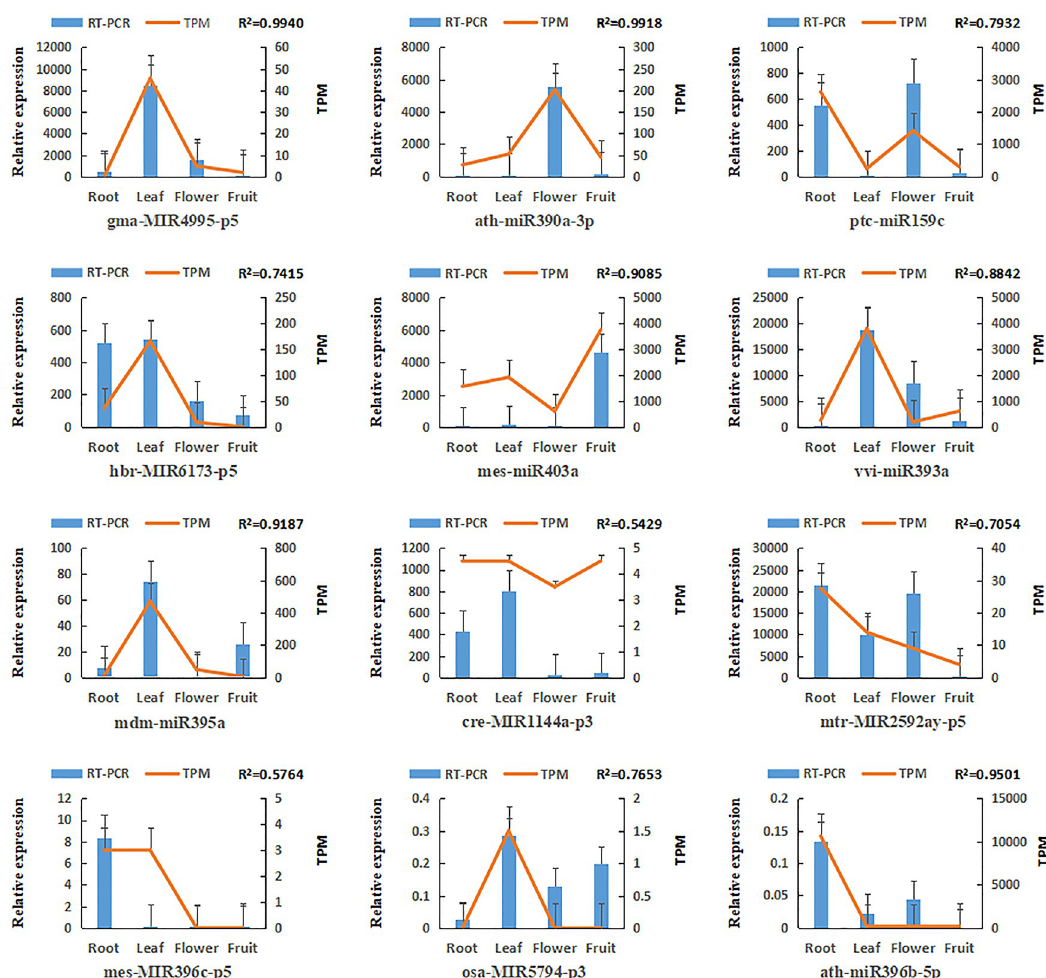
Fig 11. Expression levels of 12 miRNAs. (The bar charts and linear diagrams indicate the RT-qPCR and TPM data of the miRNAs, separately. The R 2 value denotes the correlation between the RT-qPCR and TPM data). Here, we found that 69 transporter-related genes were differentially expressed in four tissues, most of which were ABC transporters, although the specific biological function of these trans- porter genes is unknown. In this study, only two miRNAs, gma-miR4388-p3 and cme- miR172d-p3, were predicted to target transporter genes, ABCC2 and TGD1 respectively. As one of the earliest cloned and characterized ABC transporters, ABCC2 transporter transports glutathione conjugates, glucuronide conjugates and chlorophyll catabolites [65–67]. Further researches revealed that ABCC2 transportseven more substrates, and is vital for polar auxin and secondary metabolite transport, lipid degradation, detoxification of exogenous toxins, plant disease resistance and stomatal function regulation [68, 69]. TGD1 , together with TGD2 and TGD3 , forms a putative ABC transport complex for lipid transportation, in which TGD1 acts as an ABC transporter permease [70]. Currently, relatively little is known regarding the transporters and mechanisms underlying the transport activity of paeoniflorin and other monoterpene glycosides. Thus, we focus on the biosynthesis in this paper, and the identifica- tion of specific transporters of monoterpene constituents and the transport mechanism will be further study in the future.